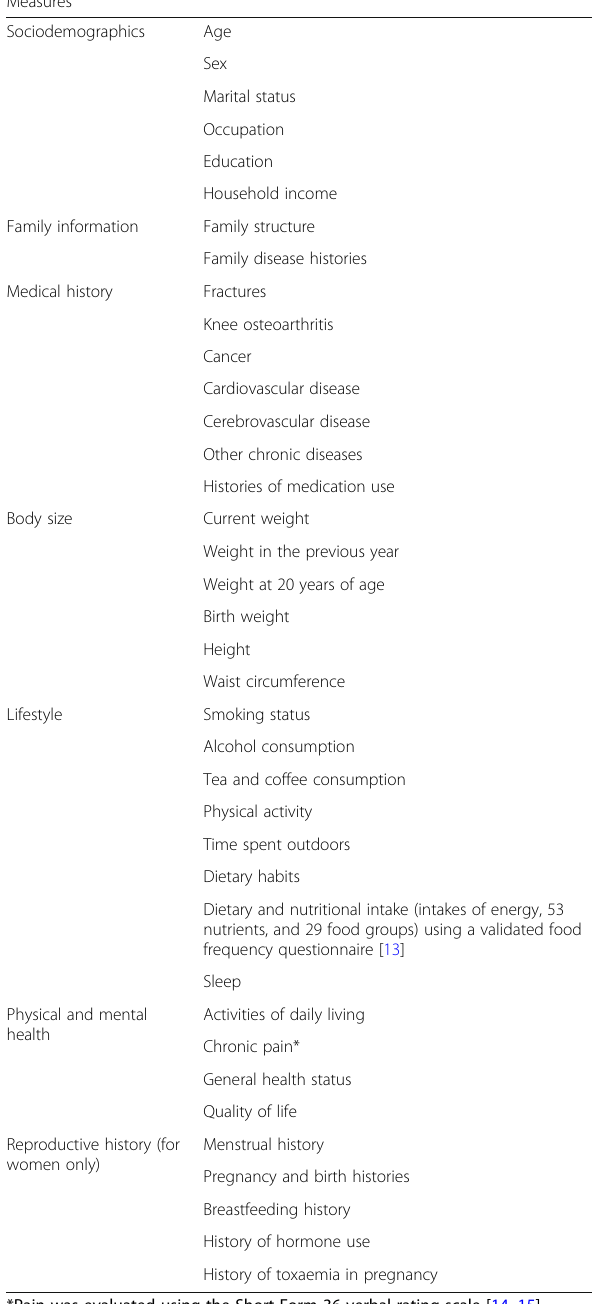
Table 1 Items of the self-administered questionnaire at baseline